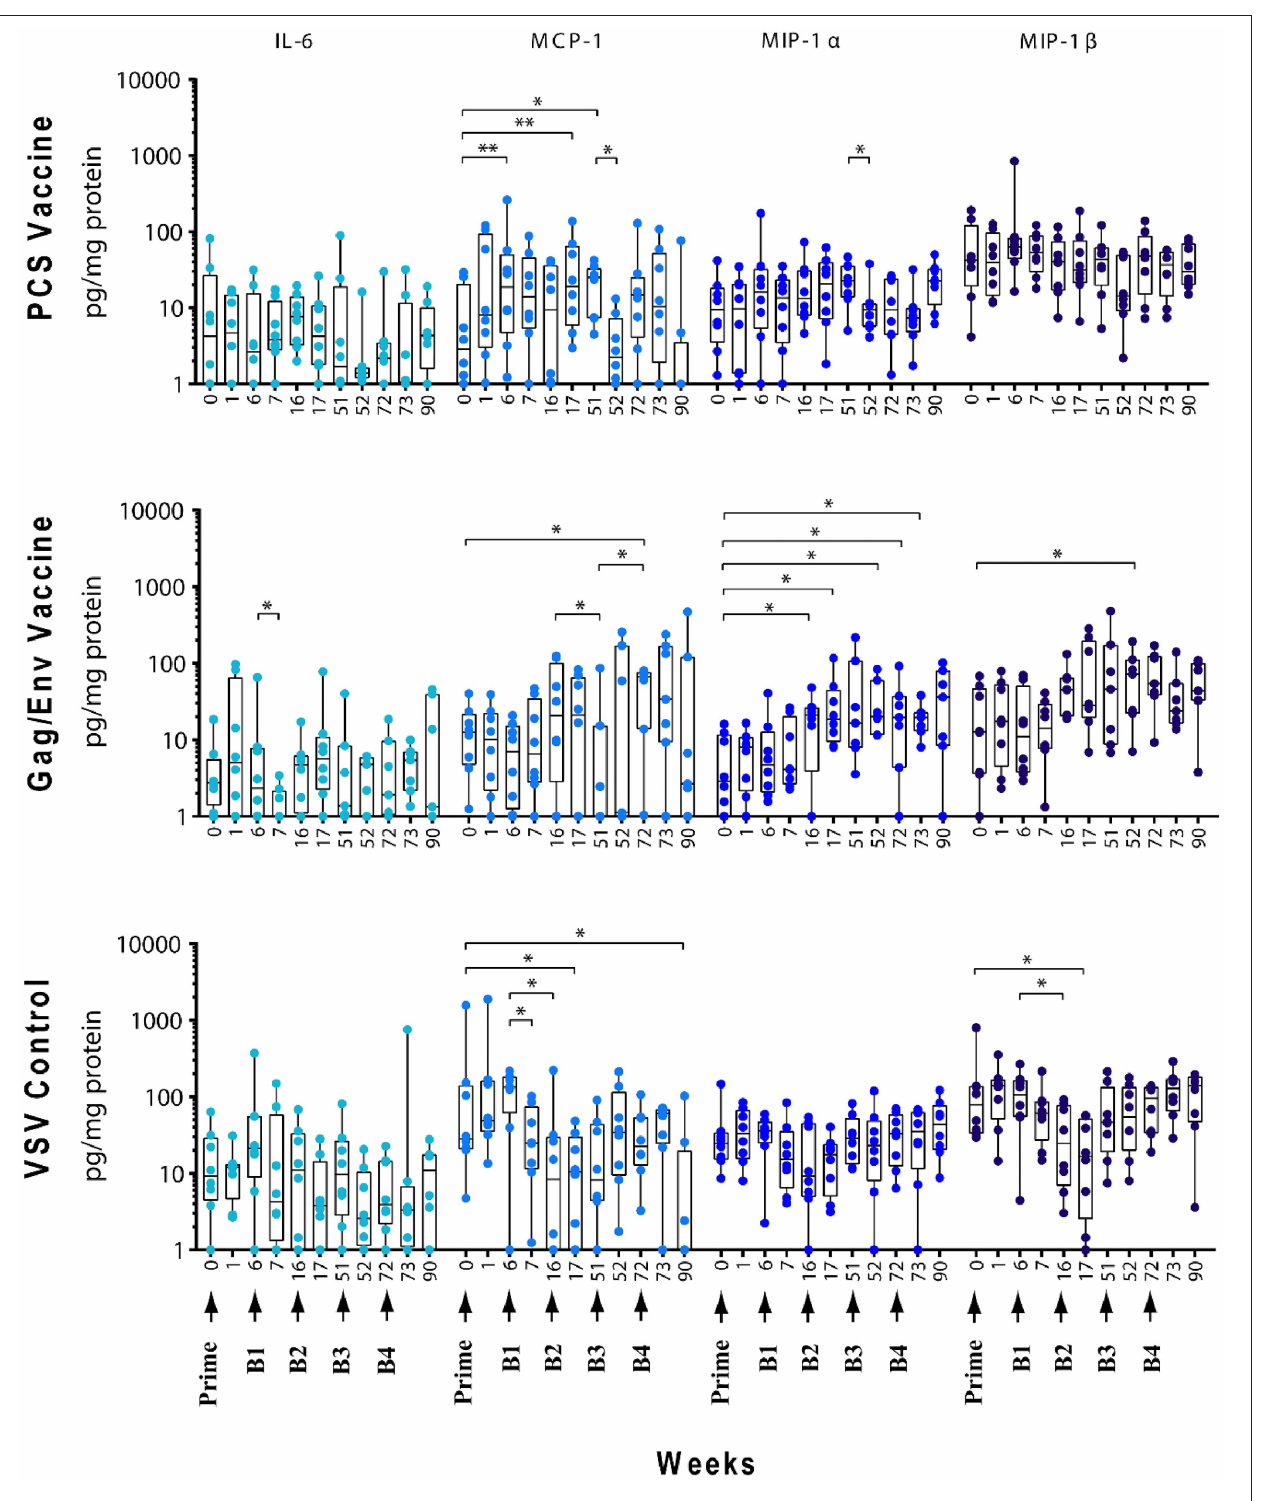
FIGURE 4 | Significant changes in the CVL levels of IL-6, MCP-1, MIP-1 α , and MIP-1 β after immunization and multiple boosts analyzed using Wilcoxon matched- pairs signed-rank paired t -test. Data presented as values from individual monkeys with median and range. Arrows indicate immunization. n = 8 monkeys/group ( n = 7 for Gag/Env). Experiments were run in duplicates. * P < 0.05 and ** P < 0.01.